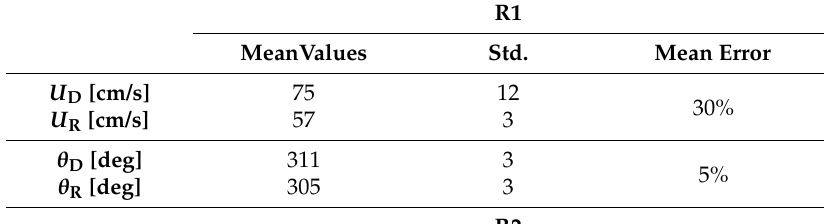
Table 3. Statistical analysis in terms of the mean values standard deviation and mean error percentage.